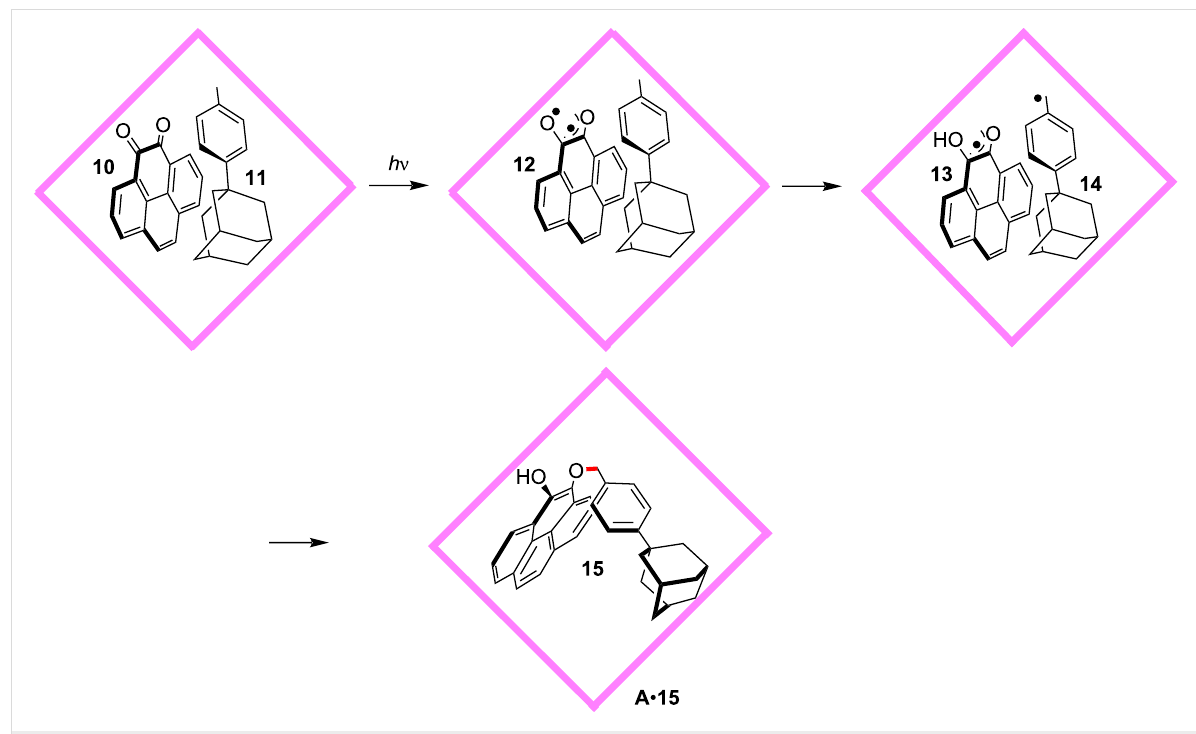
Figure 3: Cage host A -mediated selective 1,4-radical addition of o -quinone 10